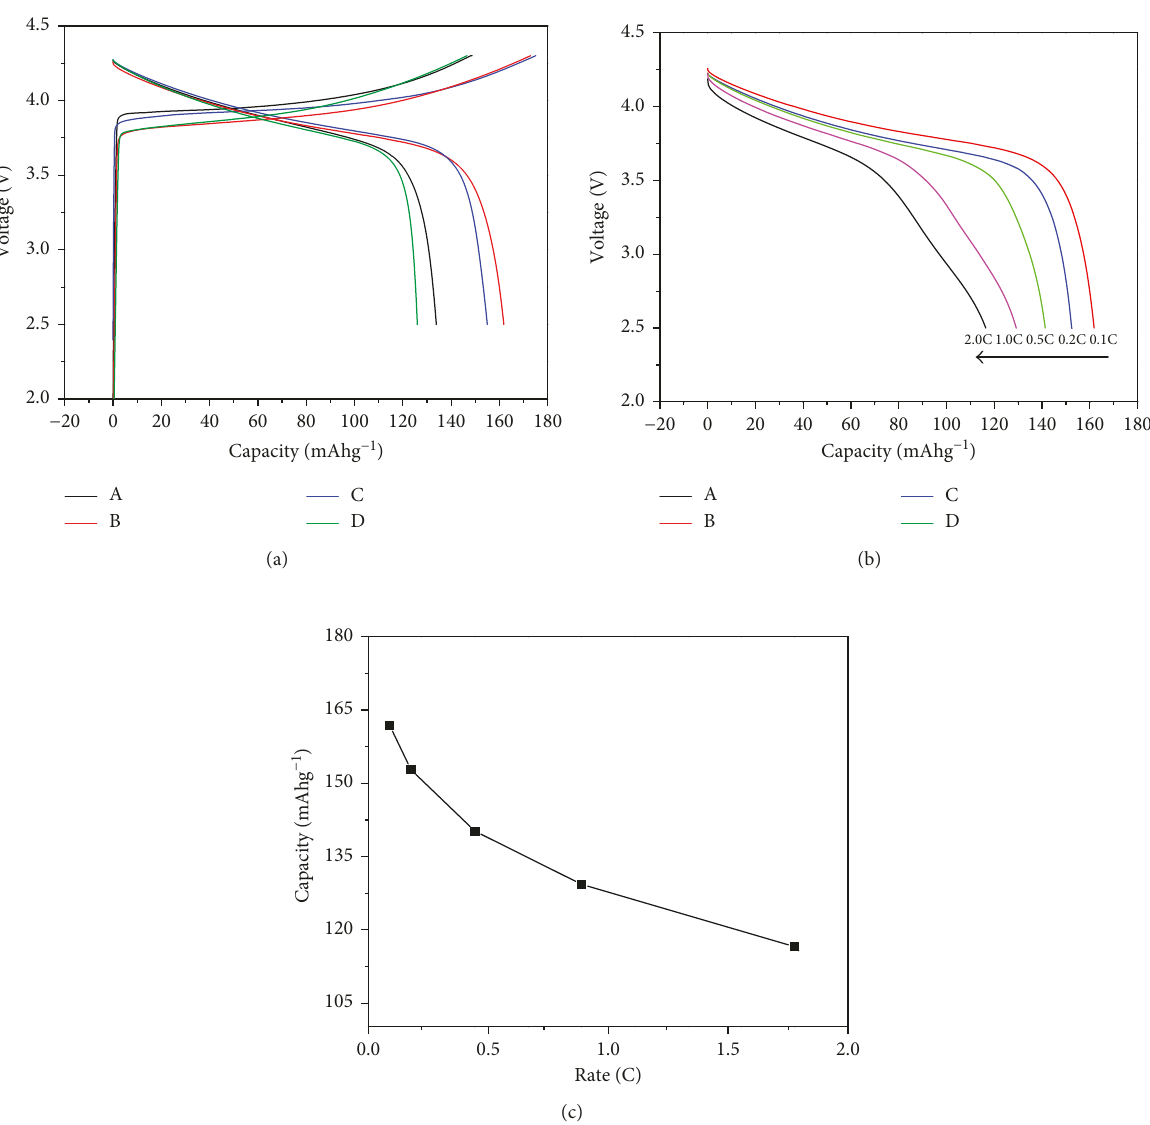
Figure 5: (a) Charge-discharge curves of LiNi ° C, (B) 750 ° C, (C) 800 ° C, 1/3 Co 1/3 Mn 1/3 O 2 powders prepared at various temperatures: (A) 700 and (D) 850 ° C at 0.1 C rate, (b) discharge curves at various currents, and (c) the dependence of specific capacity on current